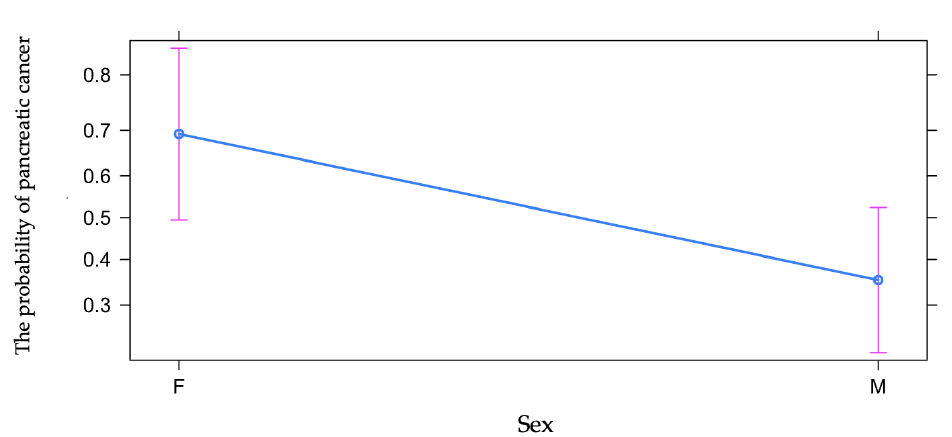
Figure 2. Predictive effect of gender on odds of pancreatic cancer vs. chronic pancreatitis. Table 1. Epidemiological and clinical parameters in patients with pancreatic cancer vs. chronic pan- creatitis.